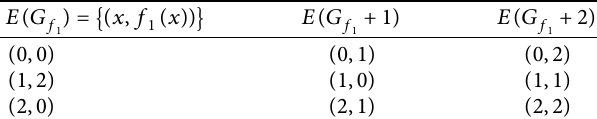
Table 4: Te graph G f 1 and it’s translates for Example 4.